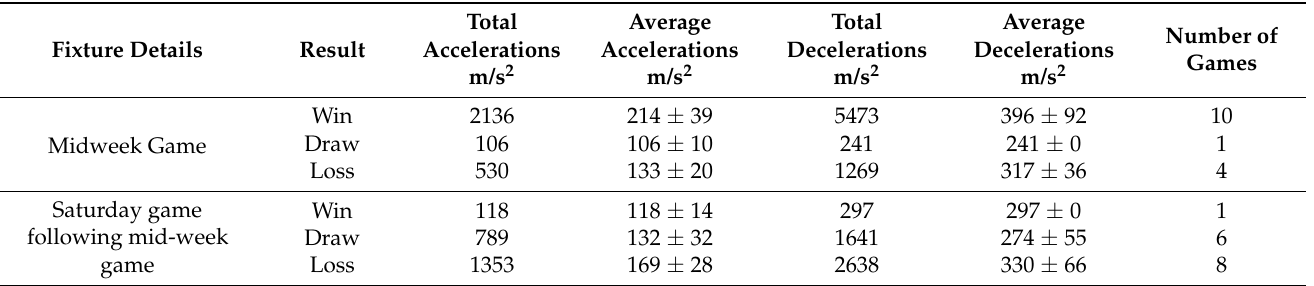
Table 2. Frequency of team high-intensity (3 m/s 2 ) accelerations and decelerations (mean ± SD) for weeks and results associated with midweek games, midweek and Saturday games and Saturday-only games for one